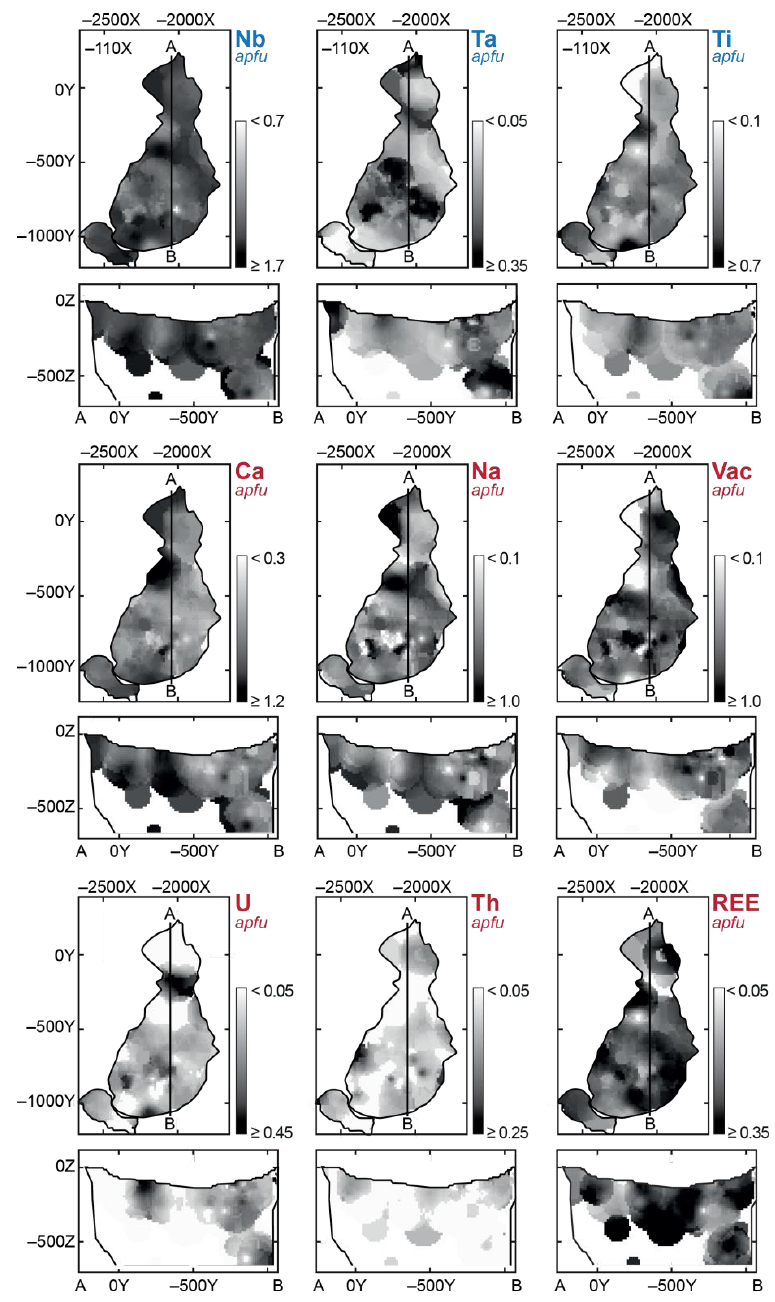
Figure 8. Distribution of the PSM basic constituents in the Kovdor phoscorite-carbonatite complex. In the unaltered PSM crystals from diopsidite, phlogopitite, phoscorite and calcite carbonatite, there are irregular variations of chemical composition between separate zones, without any clear trends from cores to margins. However, in host foidolite, marginal zones of pyrochlore crystals are constantly enriched in Ca, Na, Th and Nb in comparison with REE-U-Ta-Ti-rich cores, and the latest dolomite carbonatite, pyrochlore grains have Na-Nb-dominant cores and Ca-U-Zr-rich margins. Besides, U-Th-rich (keno)pyrochlore grains often have secondary zonation due to leaching of A